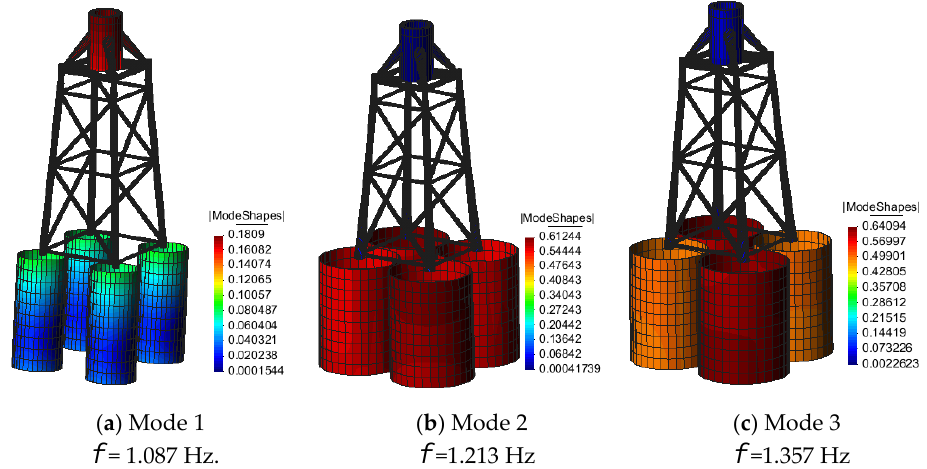
Figure 13. Mode shapes of the jacket-suction bucket piles with soil behavior using the American Petroleum Institute (API) method. ( a ) 1st mode shape; ( b ) 2nd mode shape; ( c ) 3rd mode shape J. Mar. Sci. Eng. 2020 , 8 , x FOR PEER REVIEW